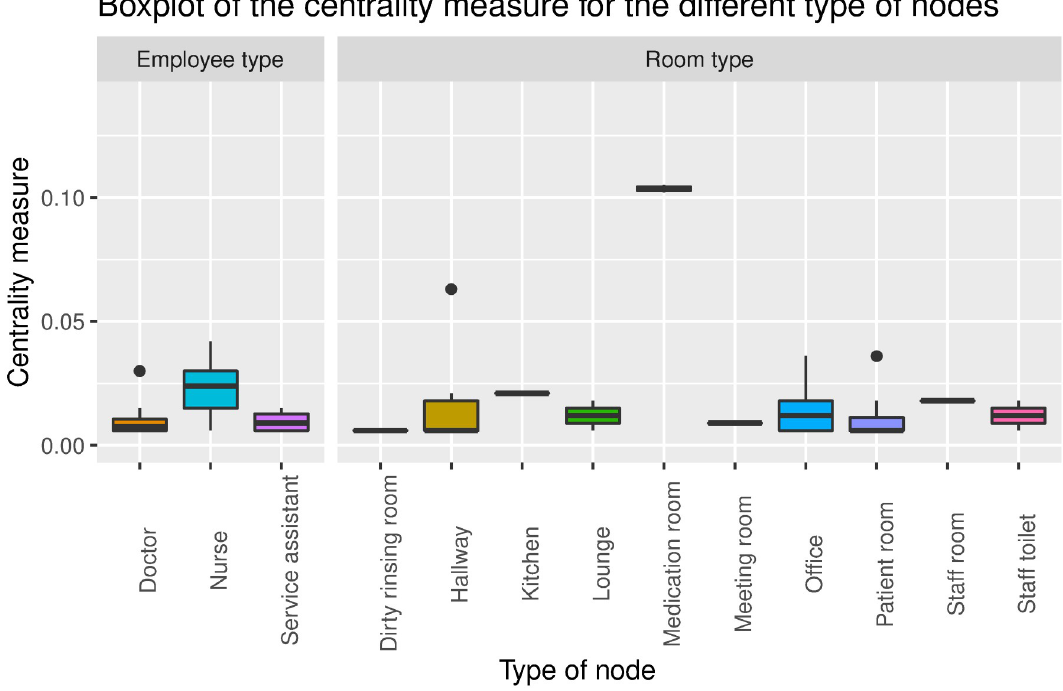
Fig 5. Boxplot showing rooms where the duration of the encounters are above 15 minutes at Aarhus University Hospital.